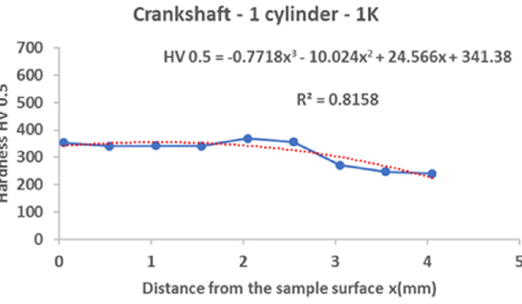
Figure 19. Regression analysis for a 3rd − order polynomial for crankshaft values on 1st cylinder.